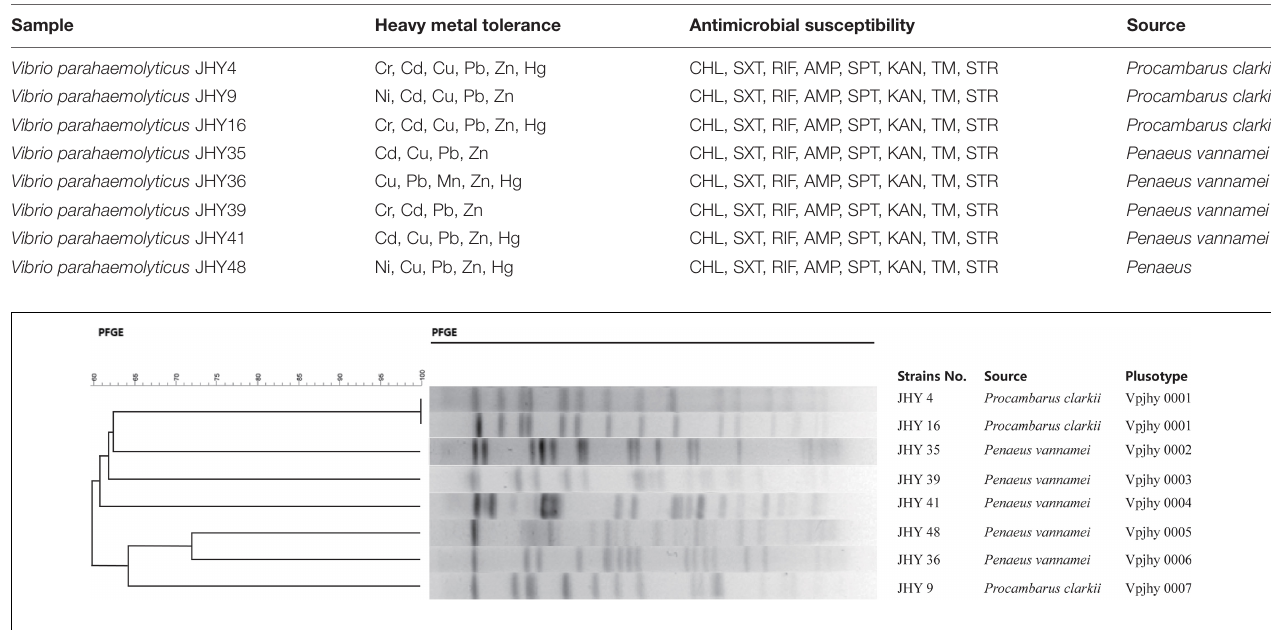
FIGURE 3 | Phylogenetic tree showing ICEs-positive V. parahaemolyticus